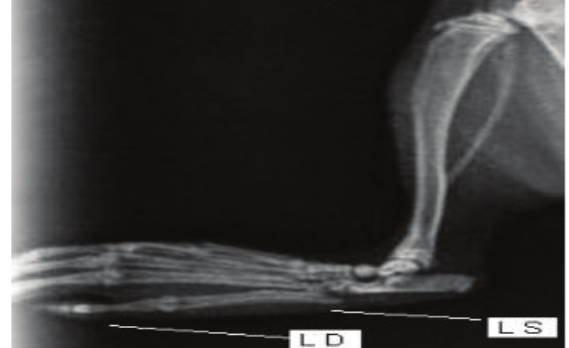
Fig-12: Therapeutic Group 12 Methanolic extract of Cassia fistula 500mg/kg treated rats shows low swelling (LS) of hind paw and low deformity (LD) of interphalangeal